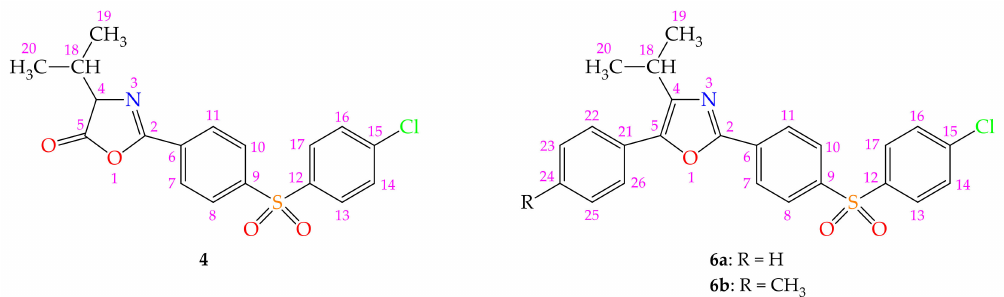
Figure 4. Structures of compounds 4 and 6a , b with the numbering of atoms (used for NMR assignments). In the 1 H-NMR spectrum of 1,3-oxazol-5(4 H )-one 4 , the H-4 signal appeared